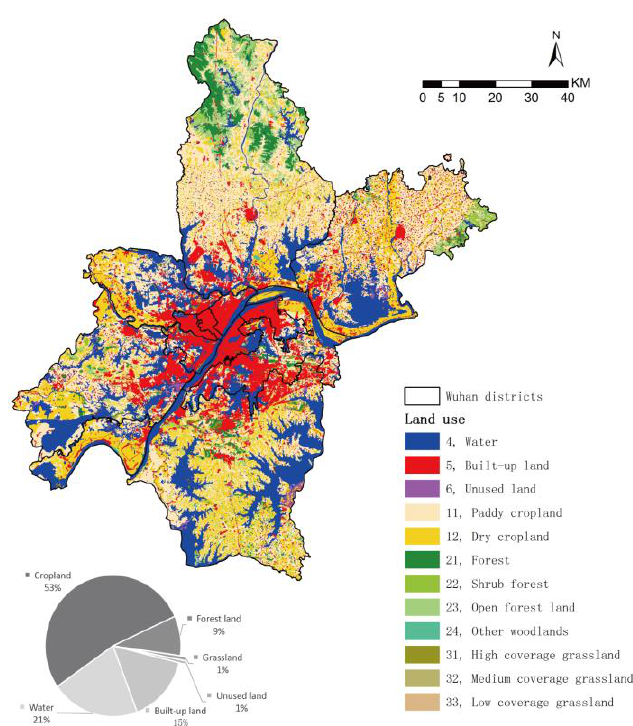
Figure 2. Wuhan land use cover.